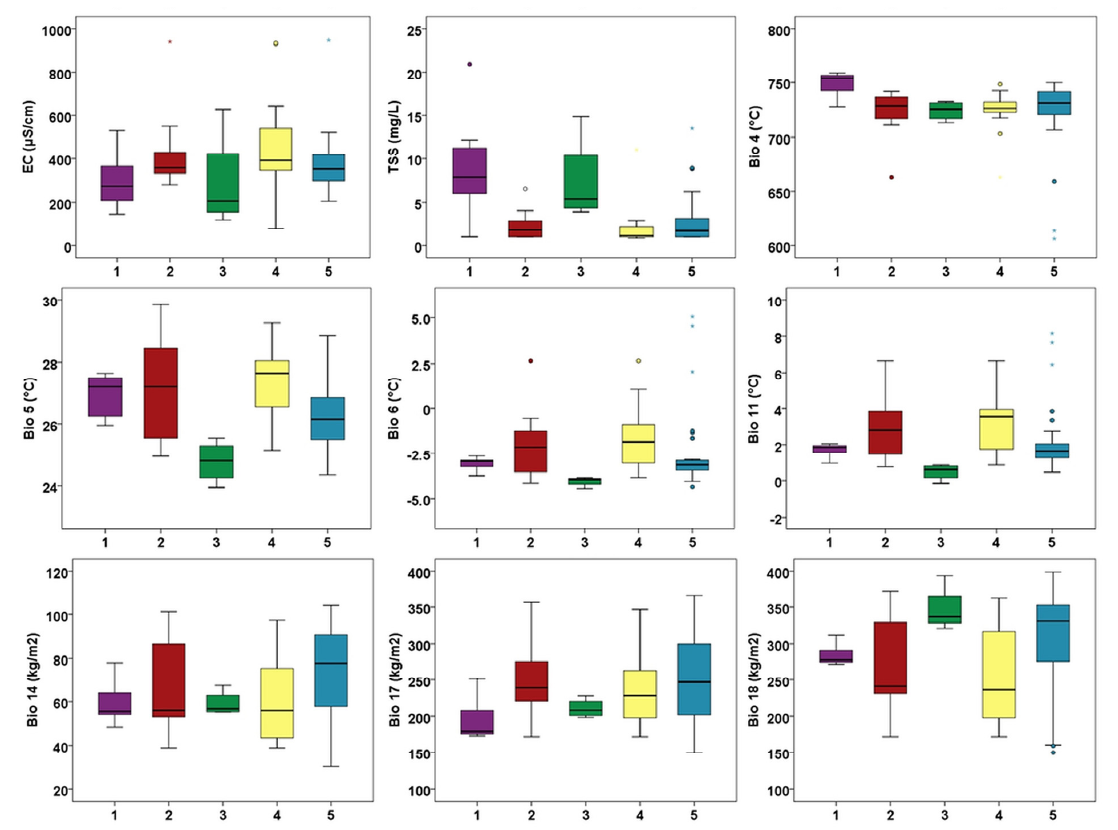
Figure 10. Boxplot diagrams of environmental variables included in CCA analysis and variables highly correlated (Spearman correlation coefficient ≥ |7|, p < 0.001) to CCA variables (for abbrevia- tions, see Table 5; outliers: o—“out” values, *—“far out” or “extreme